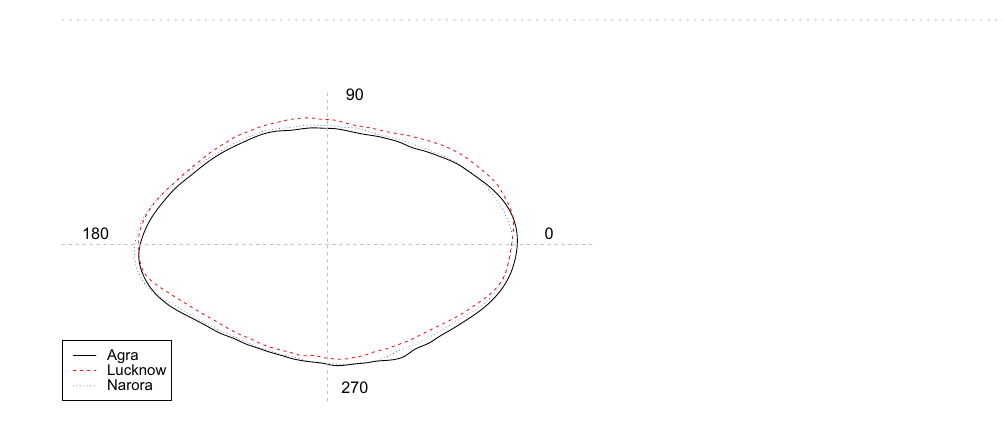
Figure 2. Dunn-Smyth Residual plots for ( a ) the otolith chemistry dataset, ( b ) the otolith shape dataset, and ( c ) the combined otolith chemistry and shape dataset. No strong patterns are visible in any of the subplots, suggesting that our MGLM models were appropriate. Colours show the variables in the analysis.